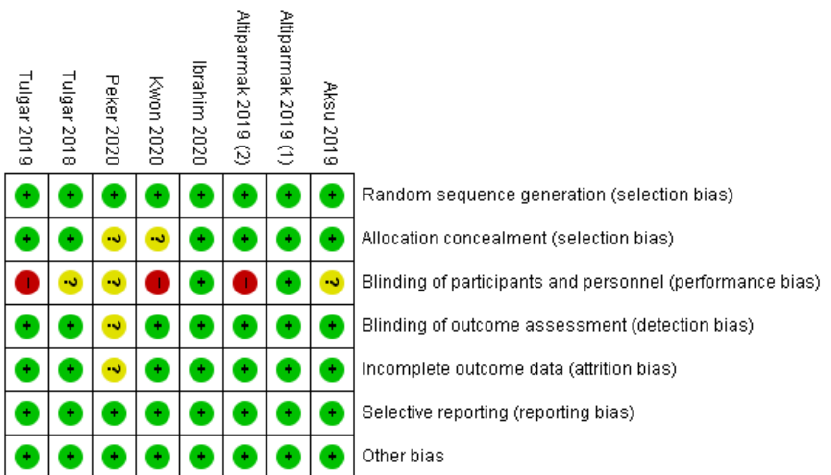
Figure 2. Risk of bias graph. Abbreviations: + , low risk of bias; ?, unclear risk of bias; − , high risk of bias.